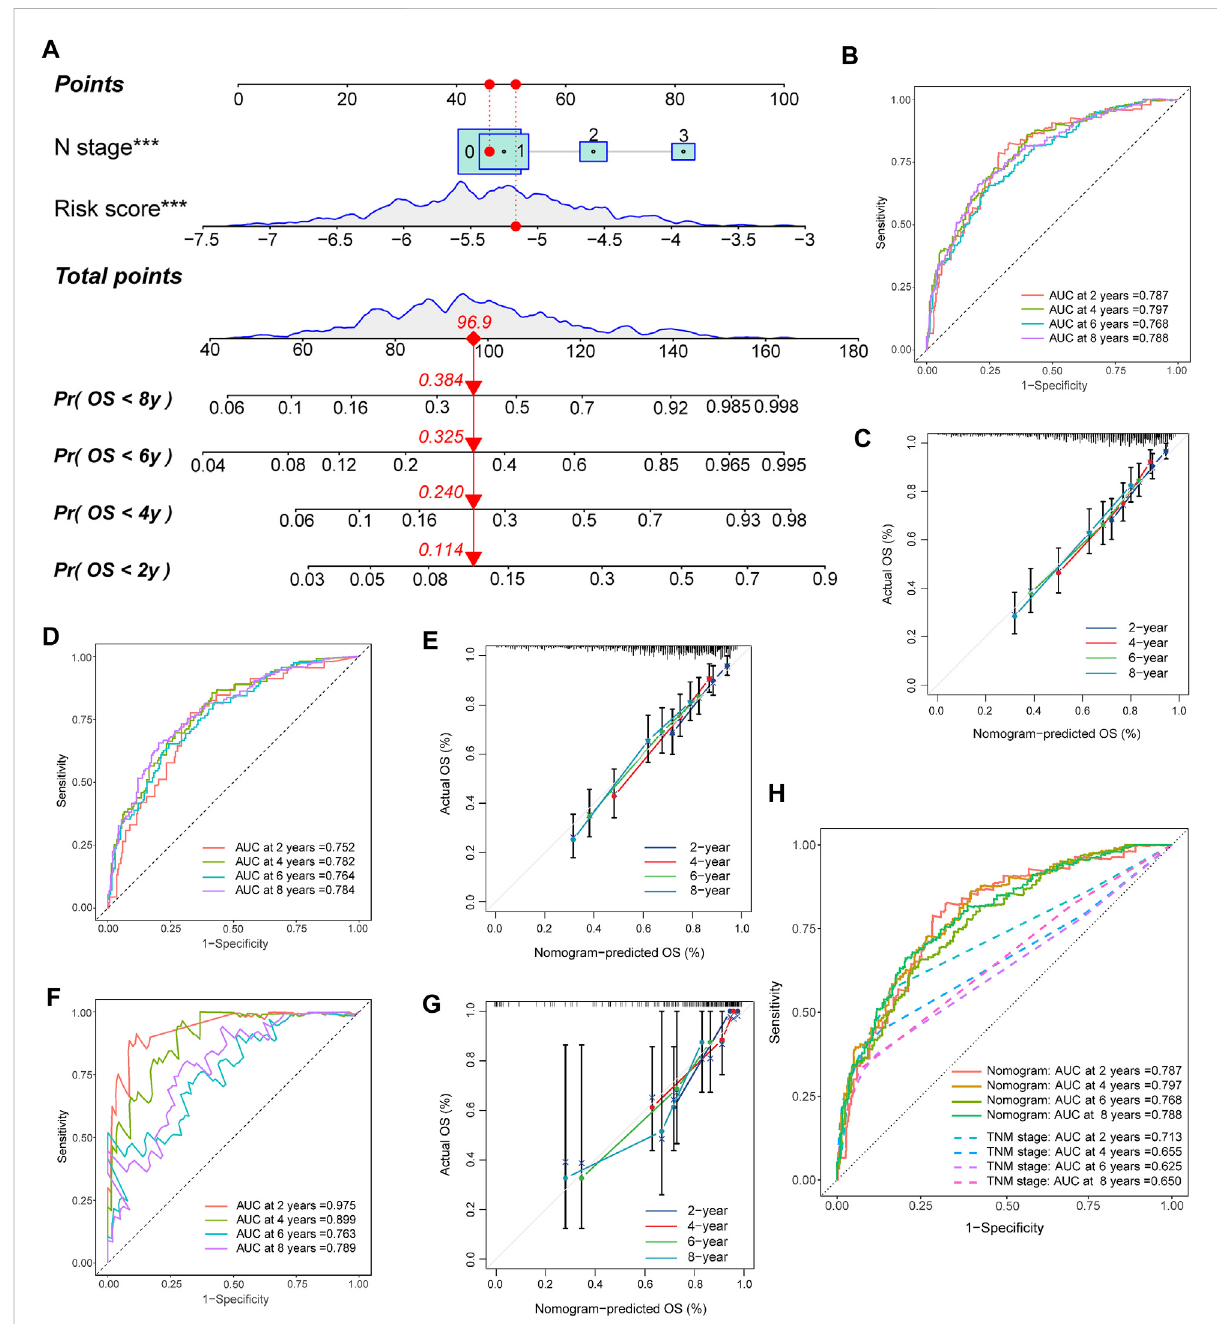
FIGURE 6 Construction and validation of the nomogram. (A) Nomogram for predicting the 2-, 4-, 6-, and 8-year OS of TNBC patients. (B,C) Nomogram and calibration curves of the nomogram for predicting the 2-, 4-, 6-, and 8-year OS of TNBC patients in the training set. (D,E) Nomogram and calibration curves of the nomogram for predicting the 2-, 4-, 6-, and 8-year OS of TNBC patients in the METABRIC set. (F,G) Nomogram and calibration curves of the nomogram for predicting the 2-, 4-, 6-, and 8-year OS of TNBC patients in the TCGA set. (H) AUCs of the nomogram and TNM stage for predicting the 2-, 4-, 6-, and 8-year OS of TNBC